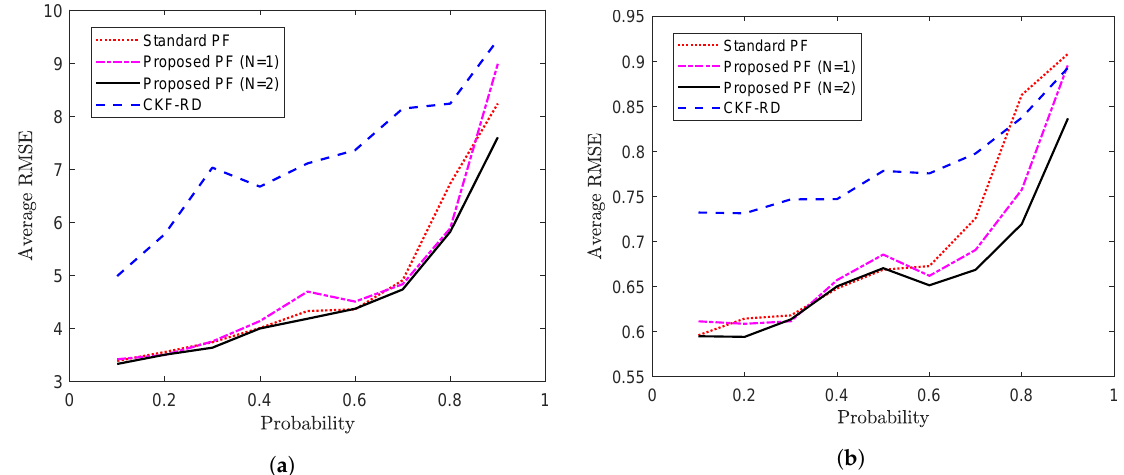
Figure 8. Average RMSE vs. probability ( a ) State x 1, k ( b ) State x 2, k (Problem 2).